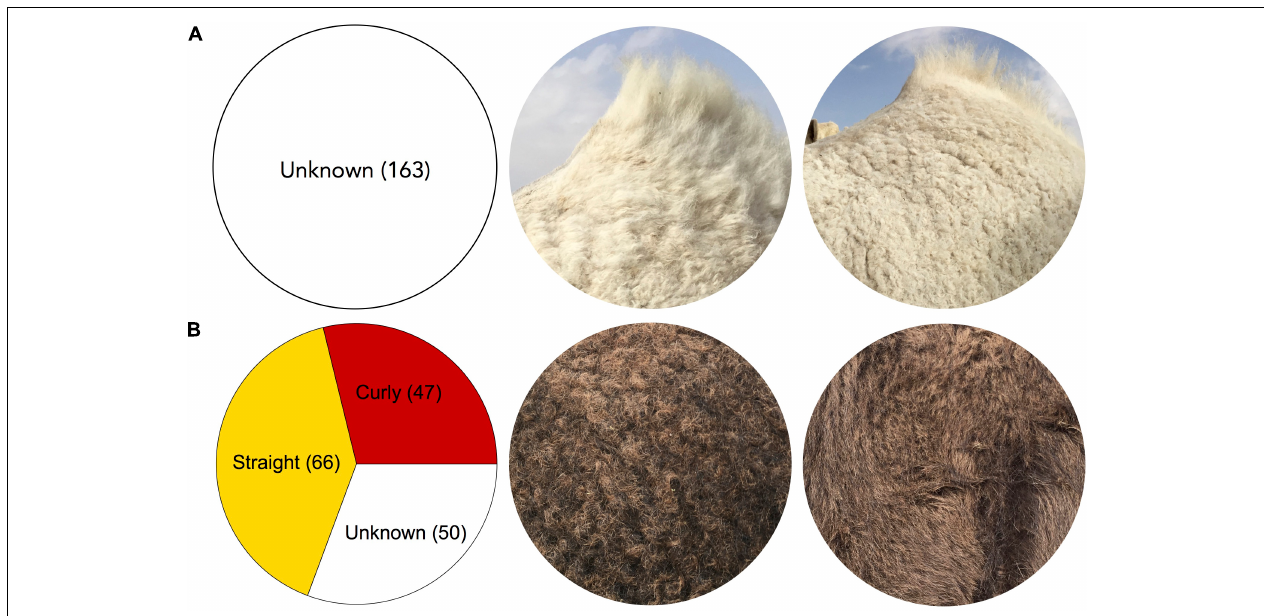
FIGURE 7 | Camel coat length and texture variation. (A) Long and short coats, respectively. (B) “Ringed” (curly) and straight camel coat textures, respectively. The Cdrom Archive contains samples of both identified coat texture phenotypes from various Mezayen breeds (B) . Images were extracted from Cdrom Archive photos (collected by the authors).